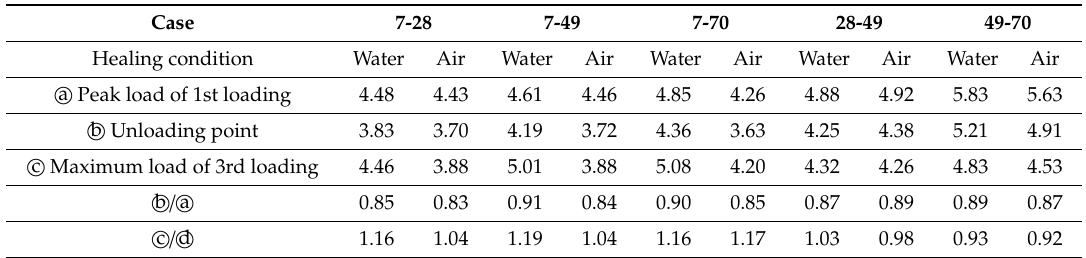
Table 4. Average load and ratio.